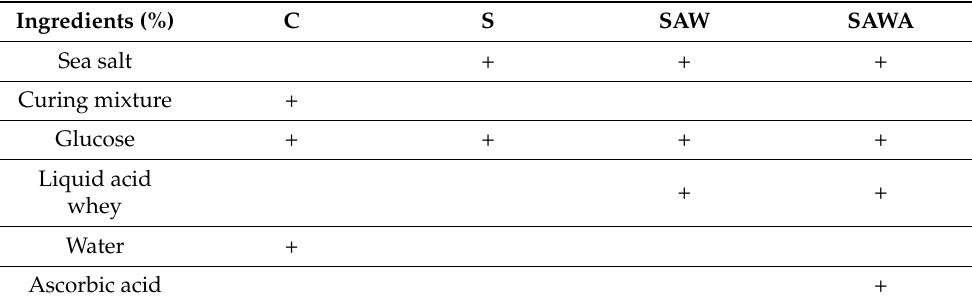
Table 1. Formulation of dry fermented